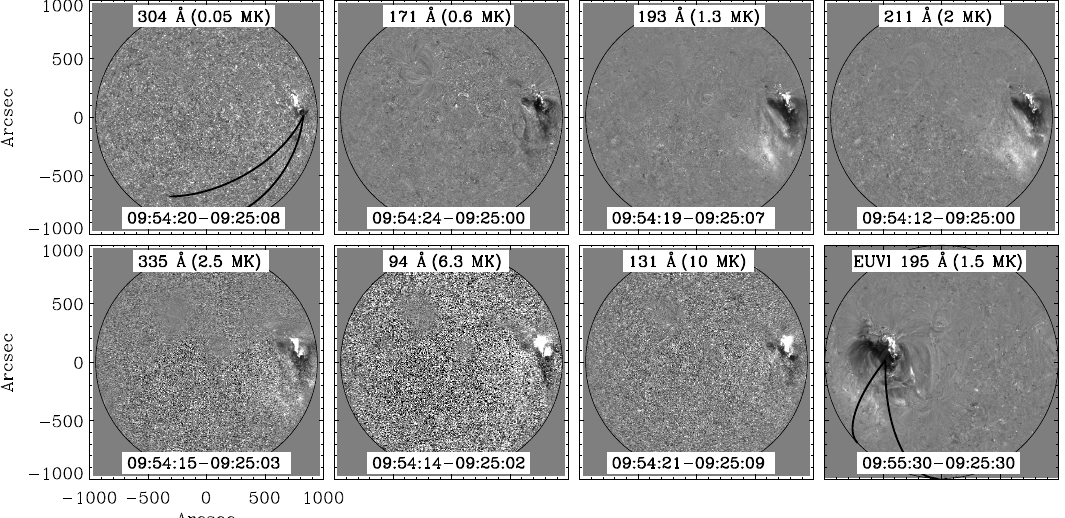
Figure 28: Multiwavelength view of the coronal EUV wave of 2010 Aug 14 as seen with SDO/AIA and STEREO/EUVI percentage difference images. The observations cover a temperature range from 0.05 to 10 MK. Note that in the non-flaring sun, the 94 ˚A and 131 ˚A channels are dominated by emission from lines that are formed at much cooler temperatures (1 and 0.4 MK, respectively) than the ones indicated in the corresponding panels. The wavefront is best seen in the 193/195 and 211 ˚A channels. Image reproduced with permission from Long et al. (2011a), copyright by